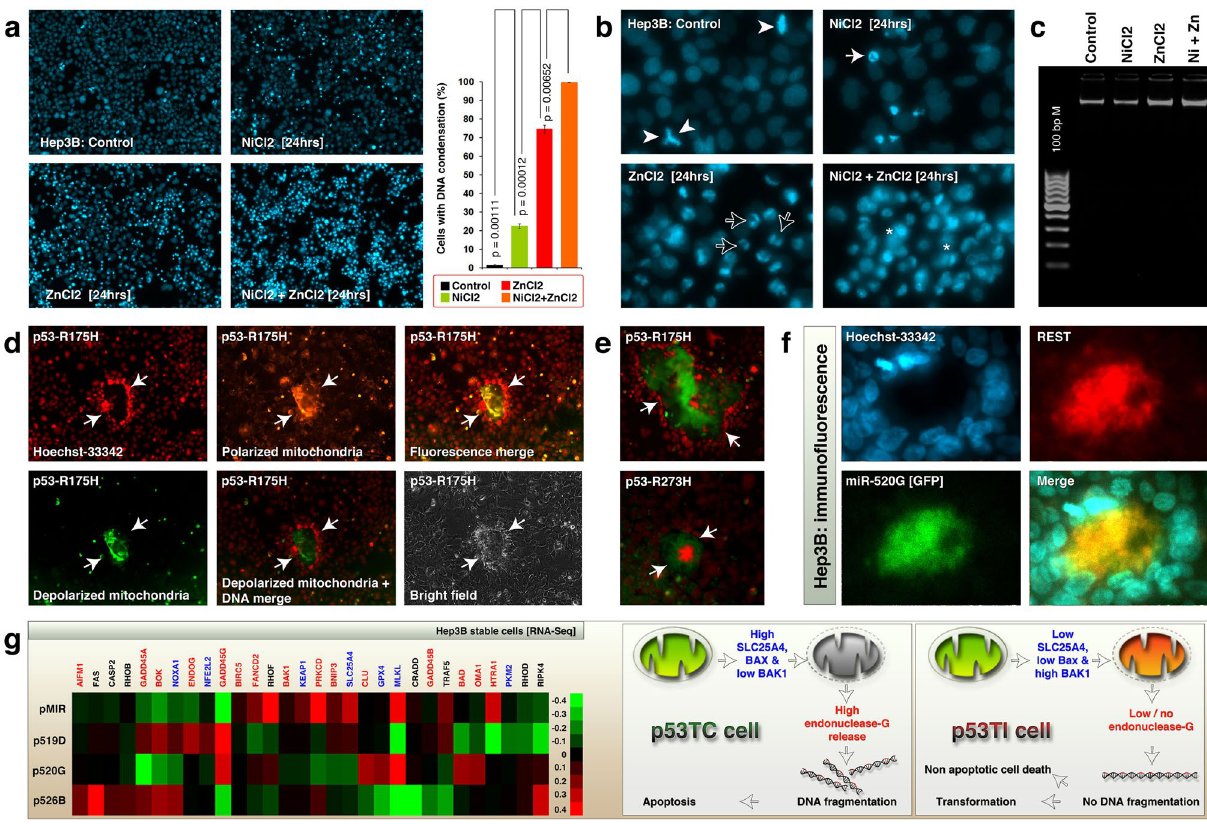
Figure 6. Nickel and zinc induce non-apoptotic cell death whereas mutant p53s and C19MC miRNAs induce transformation of Hep3B cells with depolarized mitochondria. ( a,b ) Nickel and zinc co-operatively induce DNA condensation in Hep3B cells that are stably overexpressed with C19MC miRNAs at 24 h of treatment (Panel- a ). The mitotic DNA condensation (arrow heads) was carefully excluded from cell death related condensation (white and hollow arrows). Note the diffuse cytoplasmic DNA in combination treatment (*) [Panel- b ]. ( c ) Neither nickel nor zinc or their combination induced DNA fragmentation at 24 h of treatment. Equal quantities of gDNA were run on 2% agarose gel. ( d,e ) Transient transfections of mutant p53s induce transformation (arrows) of Hep3B cells with mitochondrial depolarization at 48 h, as evaluated by JC1 and Hoechst-33342 staining. The microscopy images were pseudo-colored as indicated. Green corresponds to JC1 staining of depolarized mitochondria (MOMP). Red corresponds to DNA in DAPI channel. ( f ) REST immunofluorescence (Red) analysis of miR-520G (GFP) stable Hep3B cells showing cellular transformation which is surrounded by Hoechst-33342 positive (Blue) nuclei. Note: miRs-519D and 526B also stimulate similar transformation (Data not shown). ( g ) Evaluation of 30 cell death regulators that shown differential expression between p53TCTI dataset (Fig. 2c) in RNA-seq data of Hep3B cells stably transfected with C19MC miRNAs (Heatmap) and potential mitochondrial depolarization alteration that may explain lack of DNA fragmentation in Fig. 6 panel-c. Right panel: Schematic representing the differences in endonuclease-G release between p53TC and p53TI cells. The DNA was created using Lightwave-3D (https:// www. newtek. com/ light wave/) v11.6.3. Rest of the image was created and composited in Adobe Photoshop CS5 (https:// www. adobe. com/ produ cts/ photo shopf amily/) v 12.0 ×